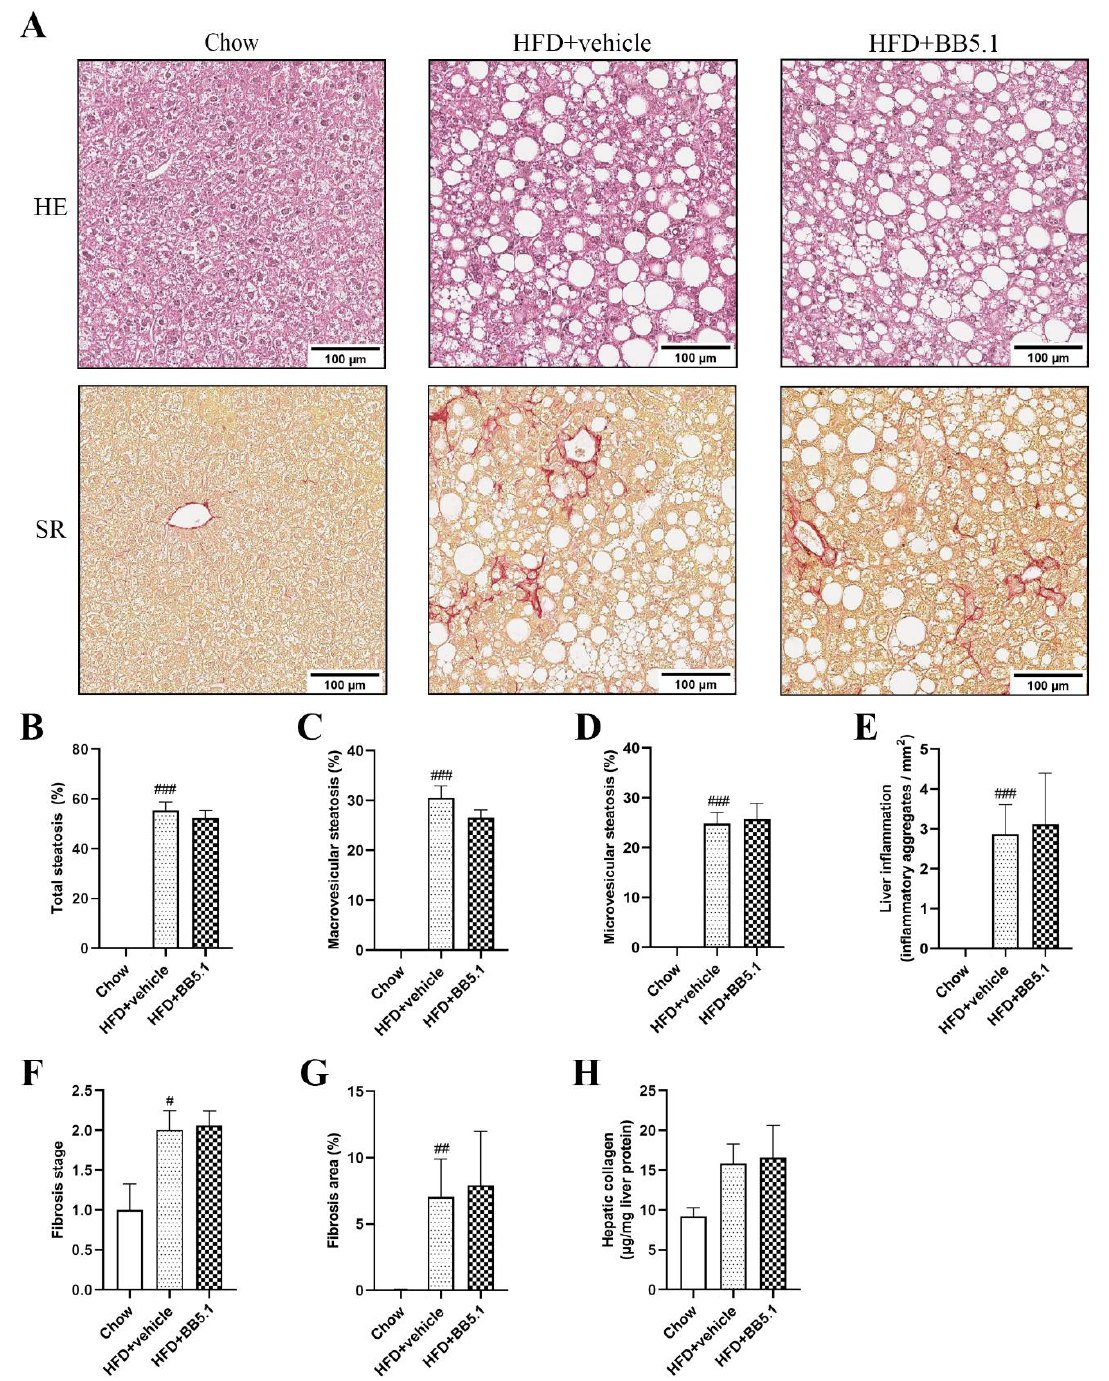
Figure 4. Anti-C5 treatment does not affect NAFLD/NASH and liver fibrosis. ( A ) Representative pictures of livers stained with Hematoxylin-Eosin (HE) and Sirius Red (SR) from Chow, HFD+vehicle and HFD+BB5.1 animals, respectively. ( B ) Liver steatosis, including ( C ) macrovesicular and ( D ) microvesicular steatosis, and ( E ) inflammation are induced by HFD feeding and not affected by the anti-C5 treatment. Fibrosis ( F ) stage and ( G ) area are also increased by HFD feeding but not altered by the anti-C5 treatment. ( H ) Hepatic collagen was not affected by anti-C5 treatment. Data are mean ± SEM. # p ≤ 0.05, ## p ≤ 0.01, ### p ≤ 0.001 Chow vs. HFD+vehicle. 2.4. Anti-C5 Treatment Reverses HFD-Induced Effects on Oxidative Phosphorylation Genes